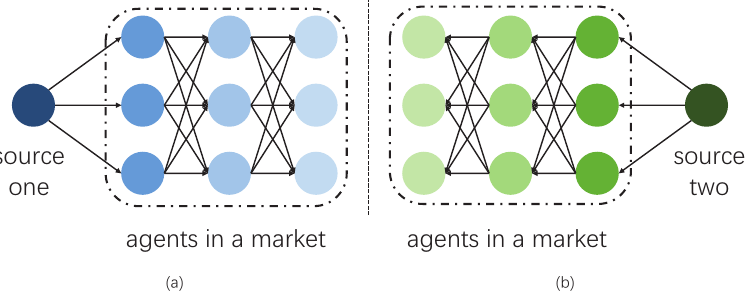
Figure 1. A demonstration of data flow with a hierarchical structure. Identical agents in a market are adaptable and sensitive to different categories of data, as in panels ( a ) and ( b